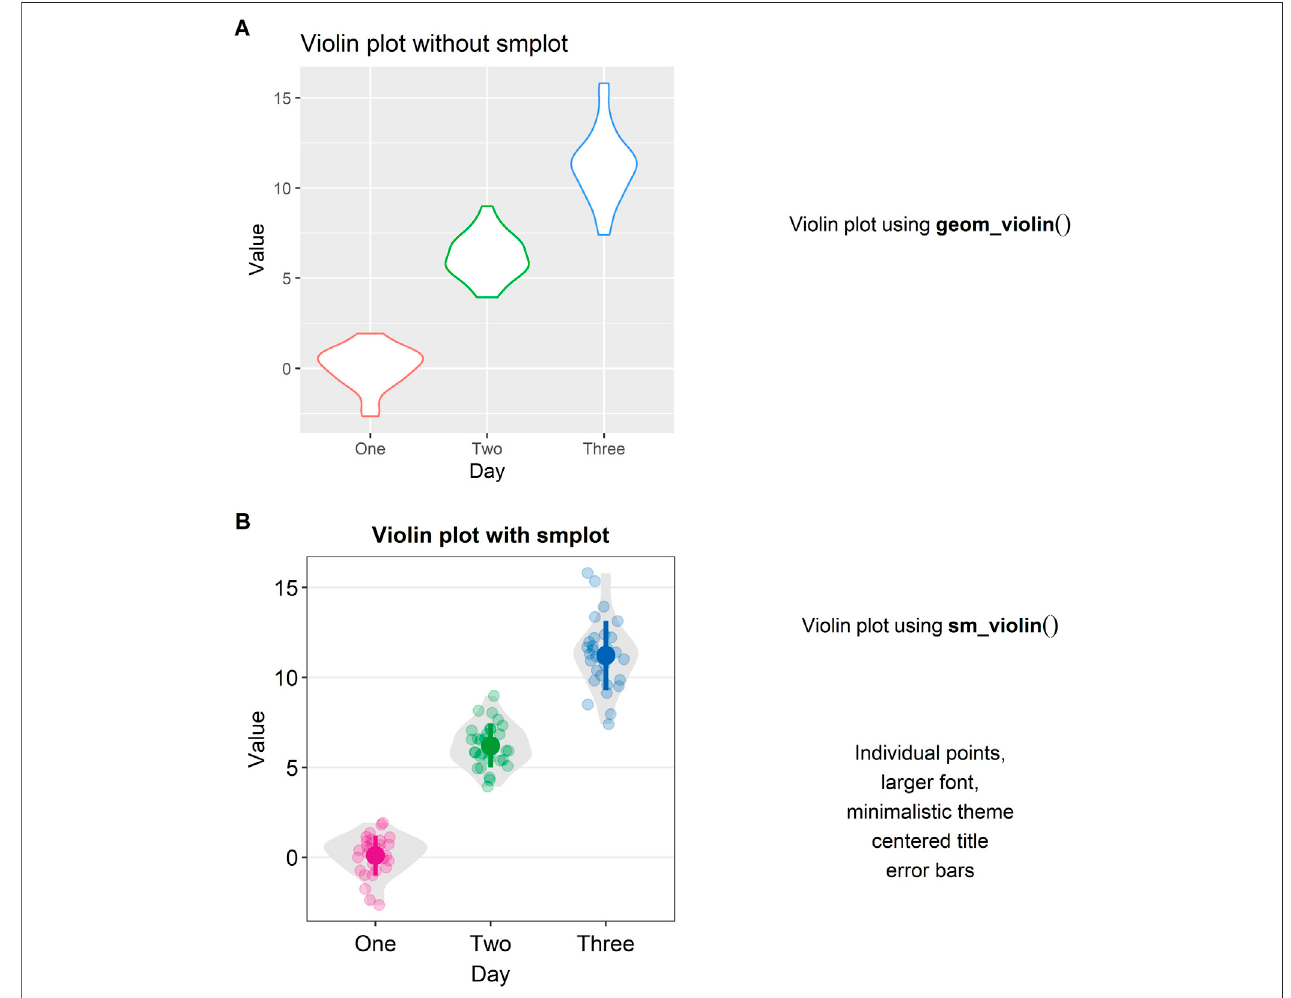
FIGURE4| Violinplotswithandwithout smplot . (A) Aviolinplotdrawnwith “ geom_violin() ” ,whichisafunctionof ggplot2 . (B) Aviolinplotdrawnwith “ sm_violin() ” . Thisfunctionautomaticallyprovidesseveralfeatures,suchasindividualdatapoints,largerfont,minimalistictheme,centeredtitle,narrowerbarwidthanderrorbars,such as standard error, standard deviation and 95% con fi dence